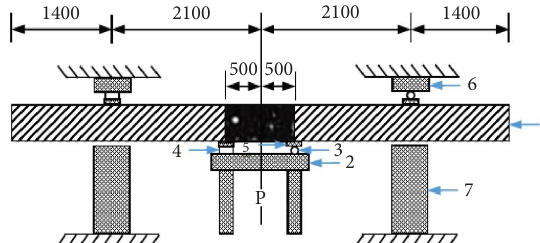
Figure 3: Schematic diagram of load equipment, where 1 is the CPCSP; 2 is the distribution beam; 3 is the rolling hinge support; 4 is the fxed hinge support; 5 is the bottom plate; 6 is the reaction pier after loading; and 7 is the protection pier before loading.